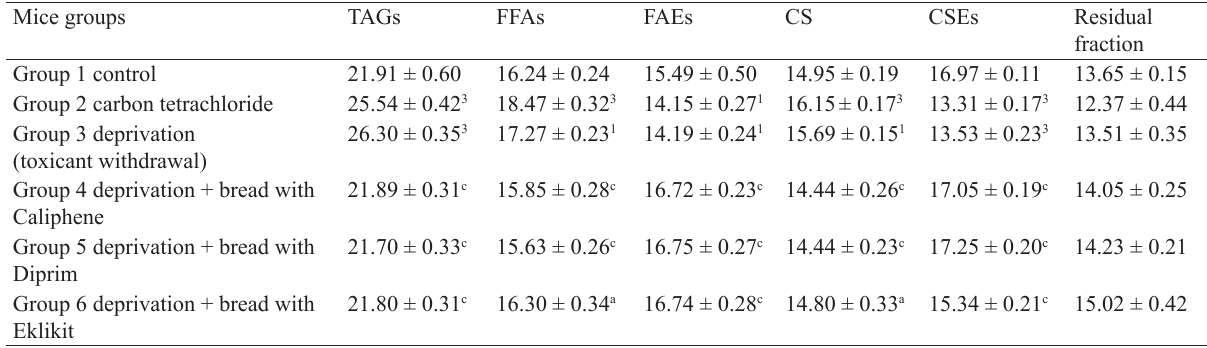
Table 5 Neutral lipid content in carbon tetrachloride intoxicated mice liver and their correction with extract-containing breads (M ± m) Mice